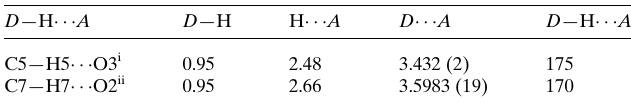
Table 1 Hydrogen-bond geometry (A˚ , (cid:2) ) for (I).